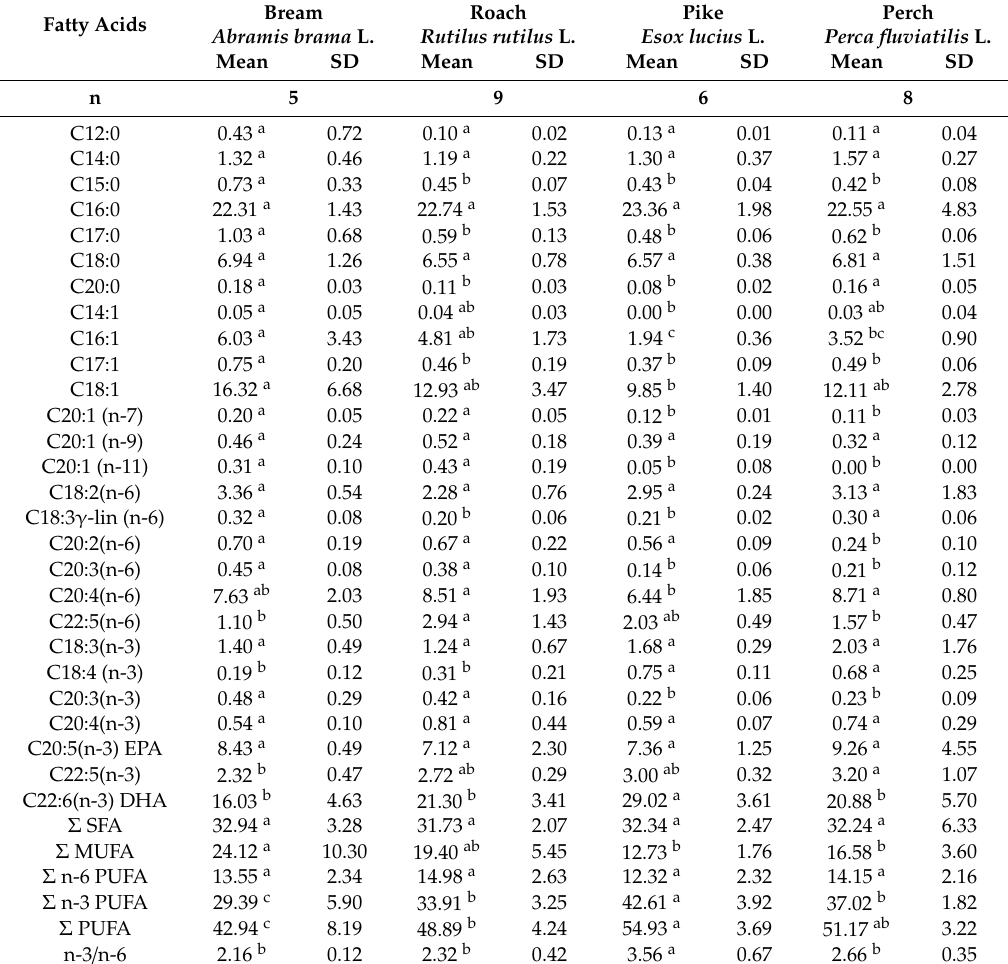
Table 3. Fatty acids composition (% of total fatty acids) in muscles of di ff erent fish species. Bream Roach Pike Perch Fatty Acids Abramis brama L. Rutilus rutilus L. Esox lucius L. Perca fluviatilis